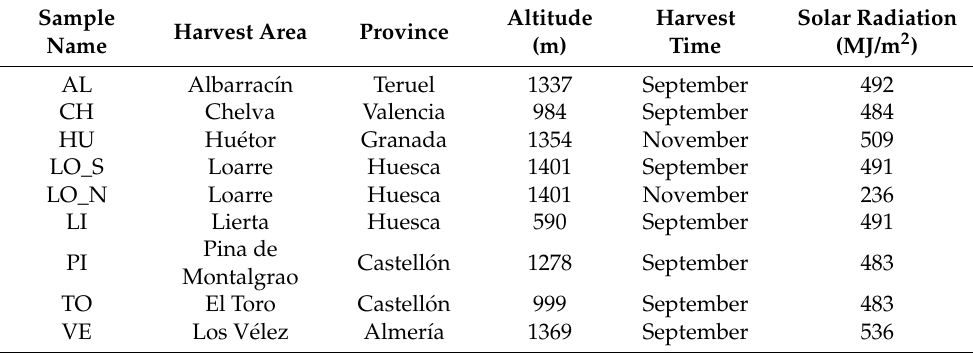
Table 1. Origin of analysed